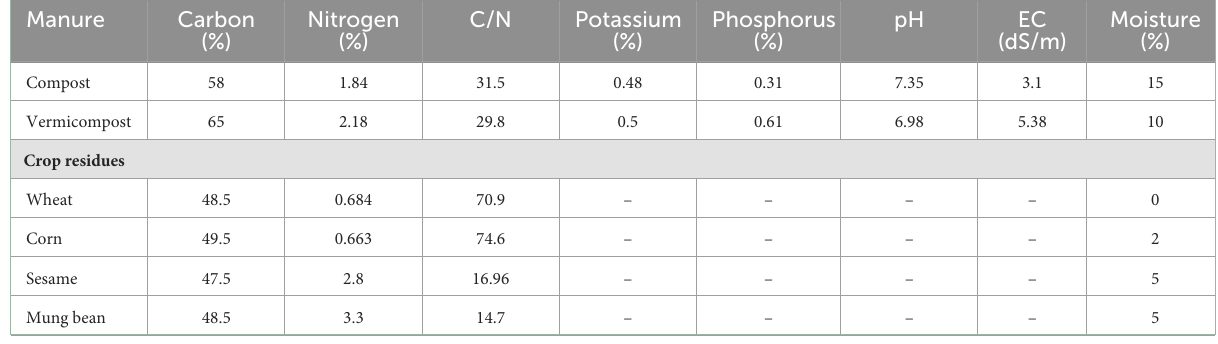
TABLE 1 Content of carbon, nitrogen, C/N, potassium, phosphorus, pH, EC, and moisture for compost and vermicompost used in the experiment. Manure Carbon Nitrogen C/N Potassium Phosphorus pH EC Moisture (%) (%) (%) (%) (dS/m) (%) Compost 58